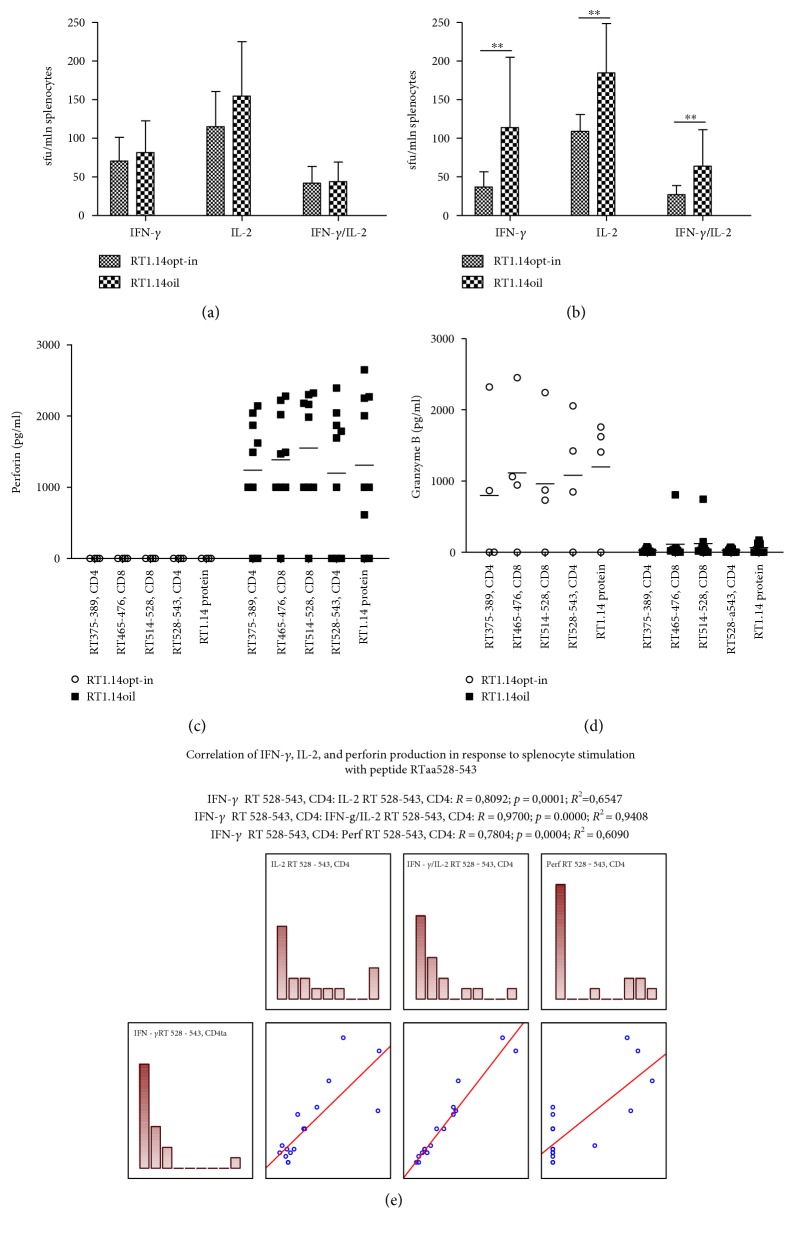
Cellular immune response of mice immunized with pVaxRT1.14opt-in and pVaxRT1.14oil. IFN-γ, IL-2, and dual (IFN-γ/IL-2) secretion by splenocytes in response to stimulation with RT1.14 protein (a) or RT1.14-derived peptide aa528-543 (b) measured by Fluorospot. Responses represent the average number of signal-forming units (sfu) per mln cells in two independent experiment runs, each done in duplicate, +SD, n = 4, ∗∗p < 0,1 (Mann–Whitney test). Secretion of perforin (c) and granzyme B (d) by splenocytes of mice immunized with pVaxRT1.14opt-in and pVaxRT1.14oil in response to stimulation with RT1.14 protein and RT1.14-derived peptides. Splenocytes were stimulated with the recombinant RT 1.14 protein and RT peptides for 3 days. After that, cell culture fluids were collected and subjected to the analysis for granzyme B and perforin by sandwich ELISA. Data represent an average value of two repeated measurements for each mouse, in pg/ml. Correlation of the parameters of cellular immune response (e).